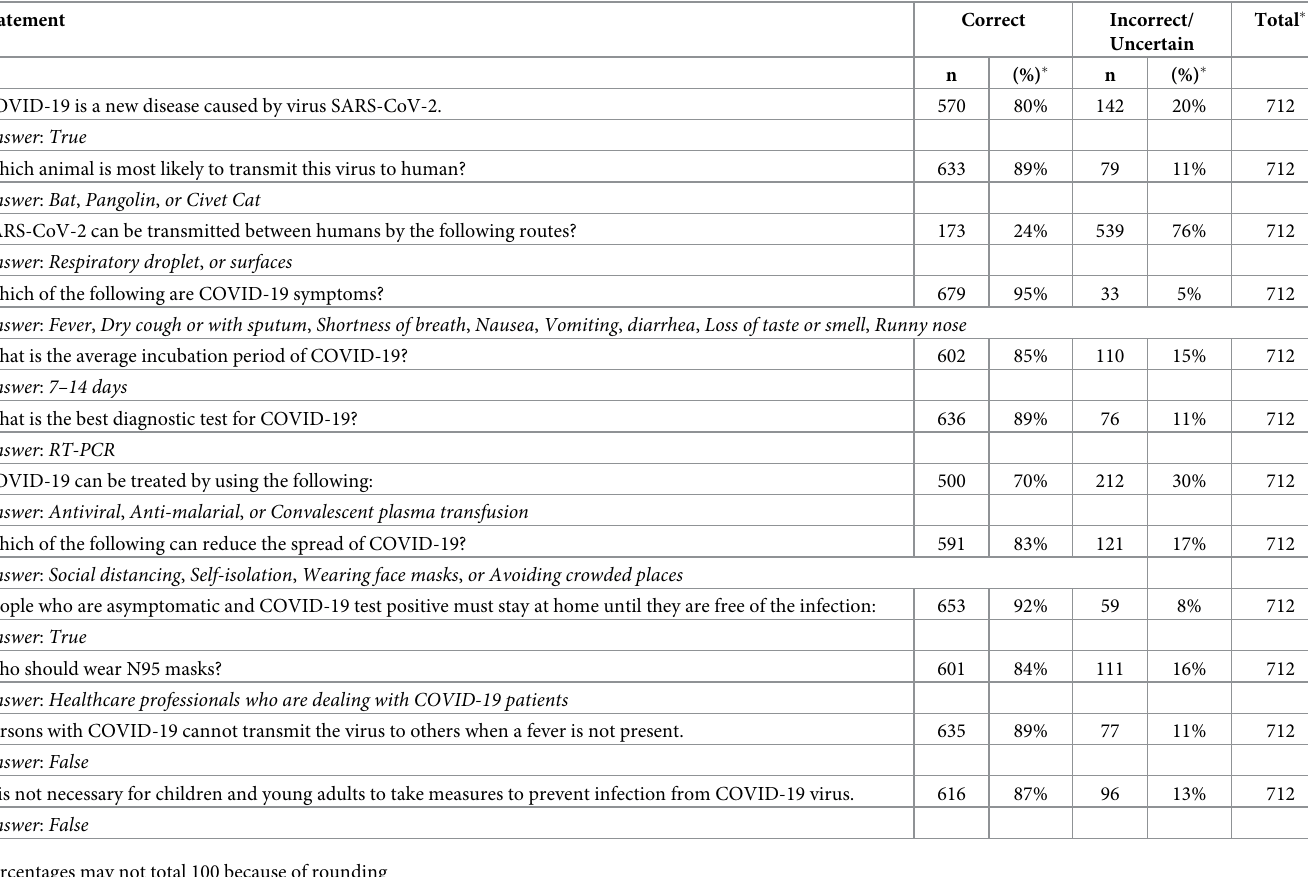
Table 3. Responses to the survey on COVID-19 knowledge.